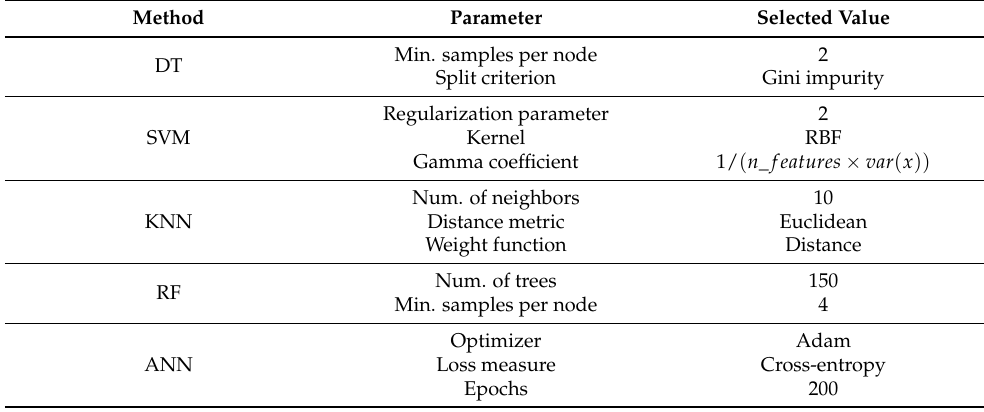
Table 4. Configuration setting per classification method. It was adjusted from FS2.